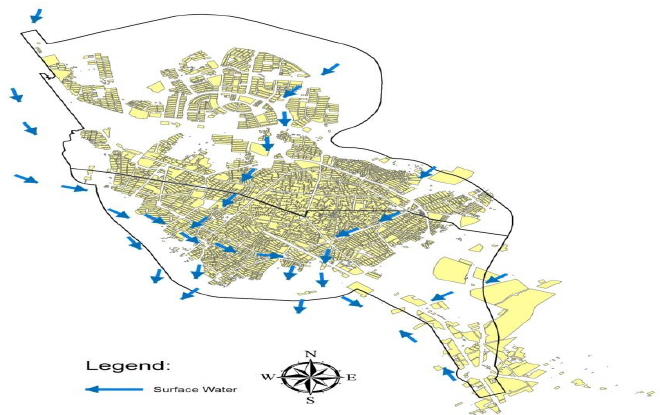
Figure 4. The map of the movement of Surface